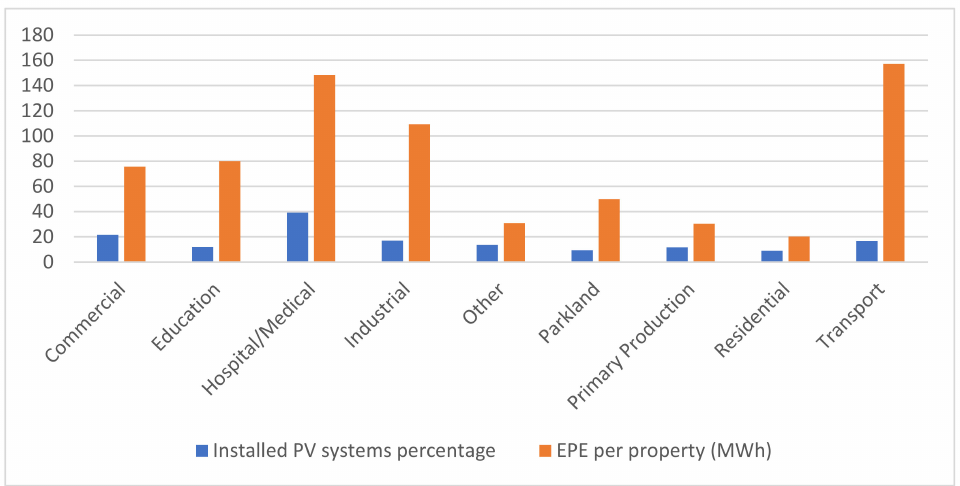
Figure 11. The installed-PV-system percentage and EPE per property in each land use